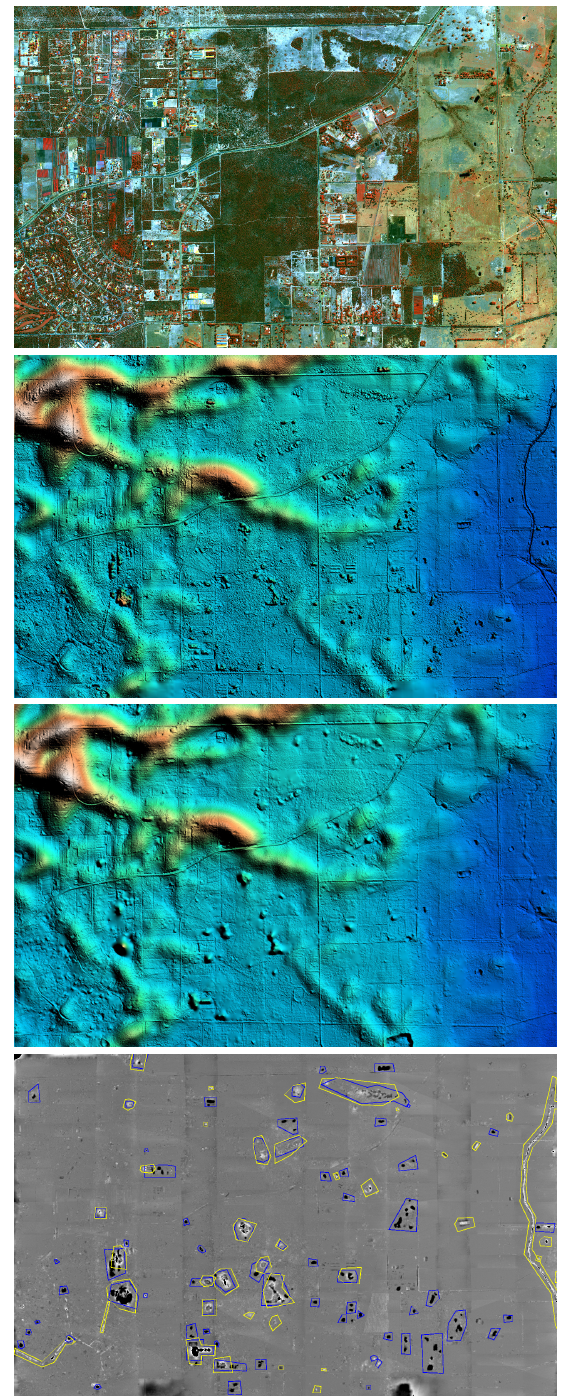
Figure 7. Comparison with the match-T generated ground eleva- tion. Shown from top: a false colour display; the DTM generated by Inpho; our DTM; and a grey scale difference of the two DTMs with the errors noted in polygons. In the last image dark shades correspond to locations where the Inpho DTM was higher than our DTM. Many more errors were found in the Inpho DTM (blue polygons) than our DTM (yellow polygons). Note that the Inpho DTM contained some stereo photography matching issues at the edge of the region, these were